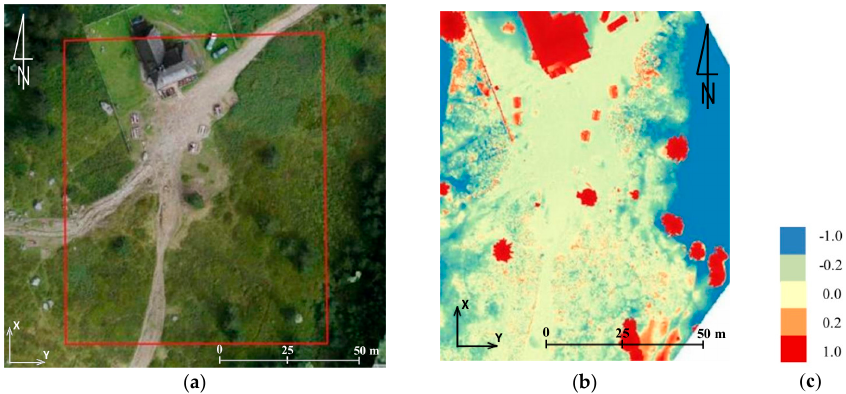
Figure 7. The shelter on Hala Kondratowa: a comparison of DTM from TLS with DSM from UAV: ( a ) the study area, ( b ) results of comparison, and ( c ) colour scale (the units given in m) (source: authors’ own study).